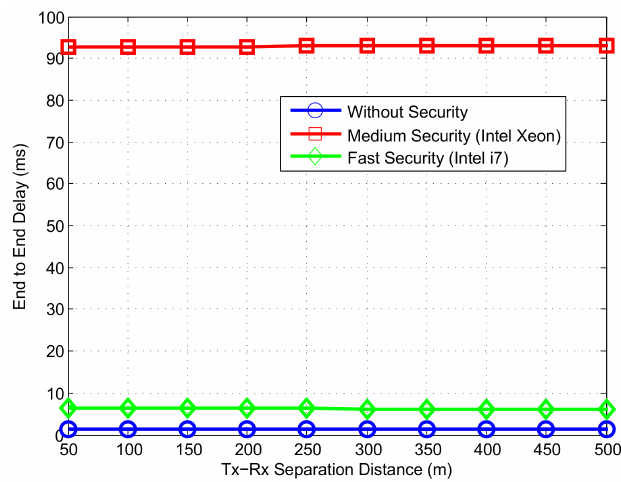
Figure 15. End-to-End Delay at different levels of security.